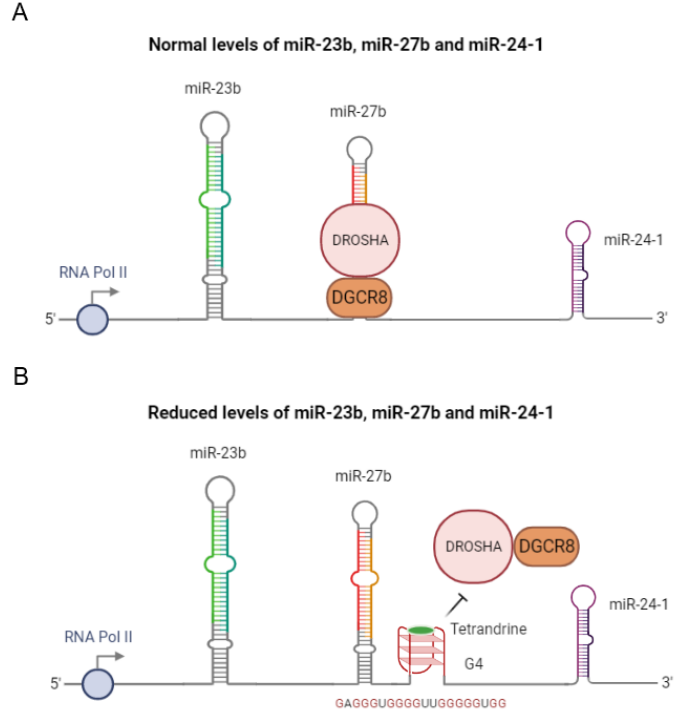
Figure 5. Representation of the influence of G-rich sequence in normal ( A ) and reduced ( B ) levels of miR-23b, miR 27b and miR-24-1. Adapted from ref. [42]. Copyright (2021), with permission from Oxford University Press.